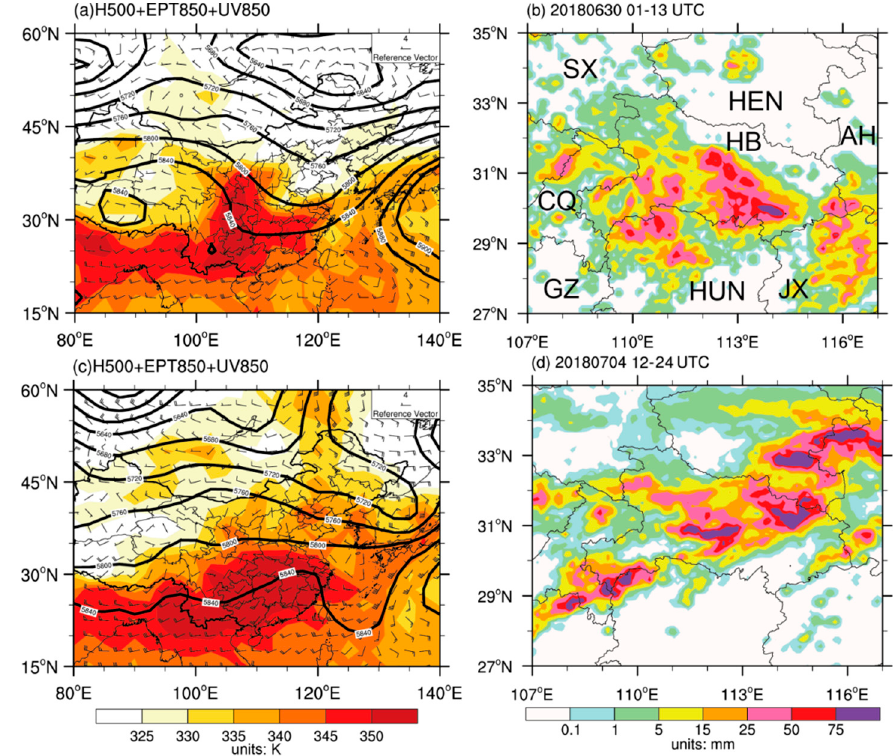
Figure 1. ERA-Interim reanalysis data at ( a ) 0000 UTC 30 June 2018 and ( c )1200 UTC 4 July, with geopotential height at 500 hPa (black solid contoured at intervals 40 gpm), and equivalent potential temperature at 850 hPa (shaded; K), superimposed with wind vectors (unit: m / s) at 850 hPa in ( a ) and ( c ). The 12-h accumulated precipitation during 01-13 UTC 30 June and 12–24 UTC 4 July is shown in ( b ) and ( d ), respectively. The symbols SX, CQ, GZ, HEN, HB, HUN, AH, and JX in the Figure 1b stand for Shan’xi, Chongqing, Guizhou, Henan, Hubei, Hunan, Anhui, and Jiangxi province, respectively.